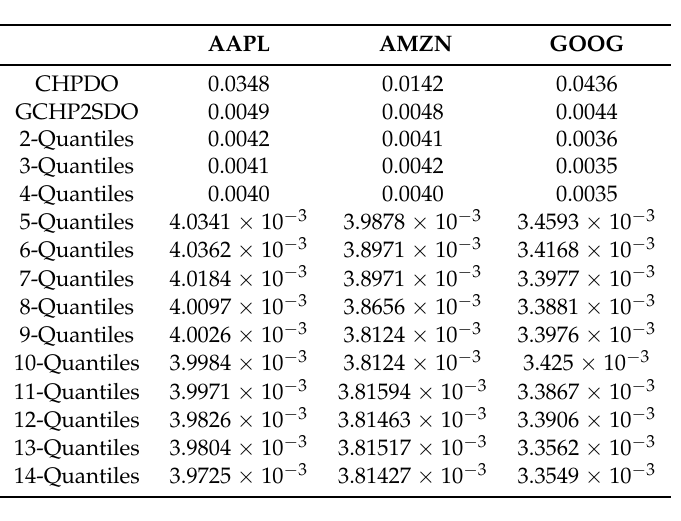
Table 12. A table of testing scores for various models. Computations were performed for up to the 40-quantile case for each stock, and this table represents a sample of that data. We note that the models stop obtaining appreciable performance gains at around 4–7 quantiles, fluctuating around the same